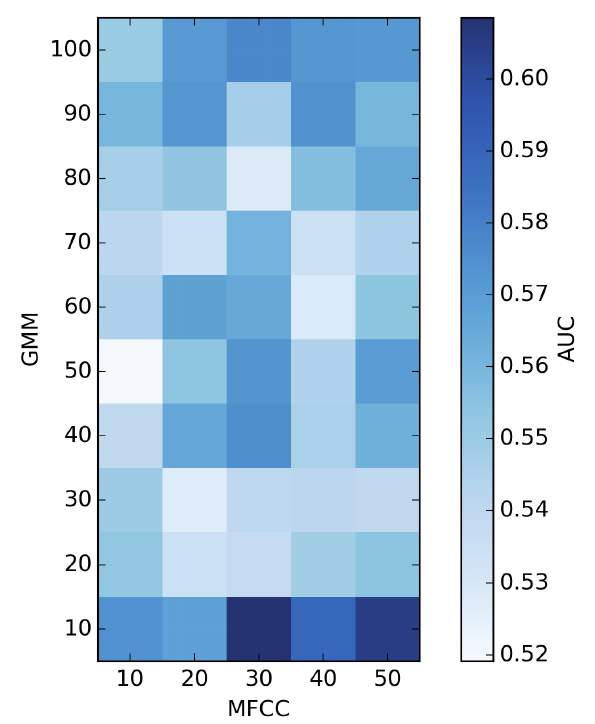
Figure 2. Evaluation of different combination of parameters in predicting differential gene expression on a gold-standard subset of 500 genes. Each square corresponds to a number of Mel- Frequency Cepstral Coefficients (MFCC) used to summarize signal and a number of centers for Gaussian Mixture Model (GMM). Colors are given by the corresponding Area Under the Curve (AUC).